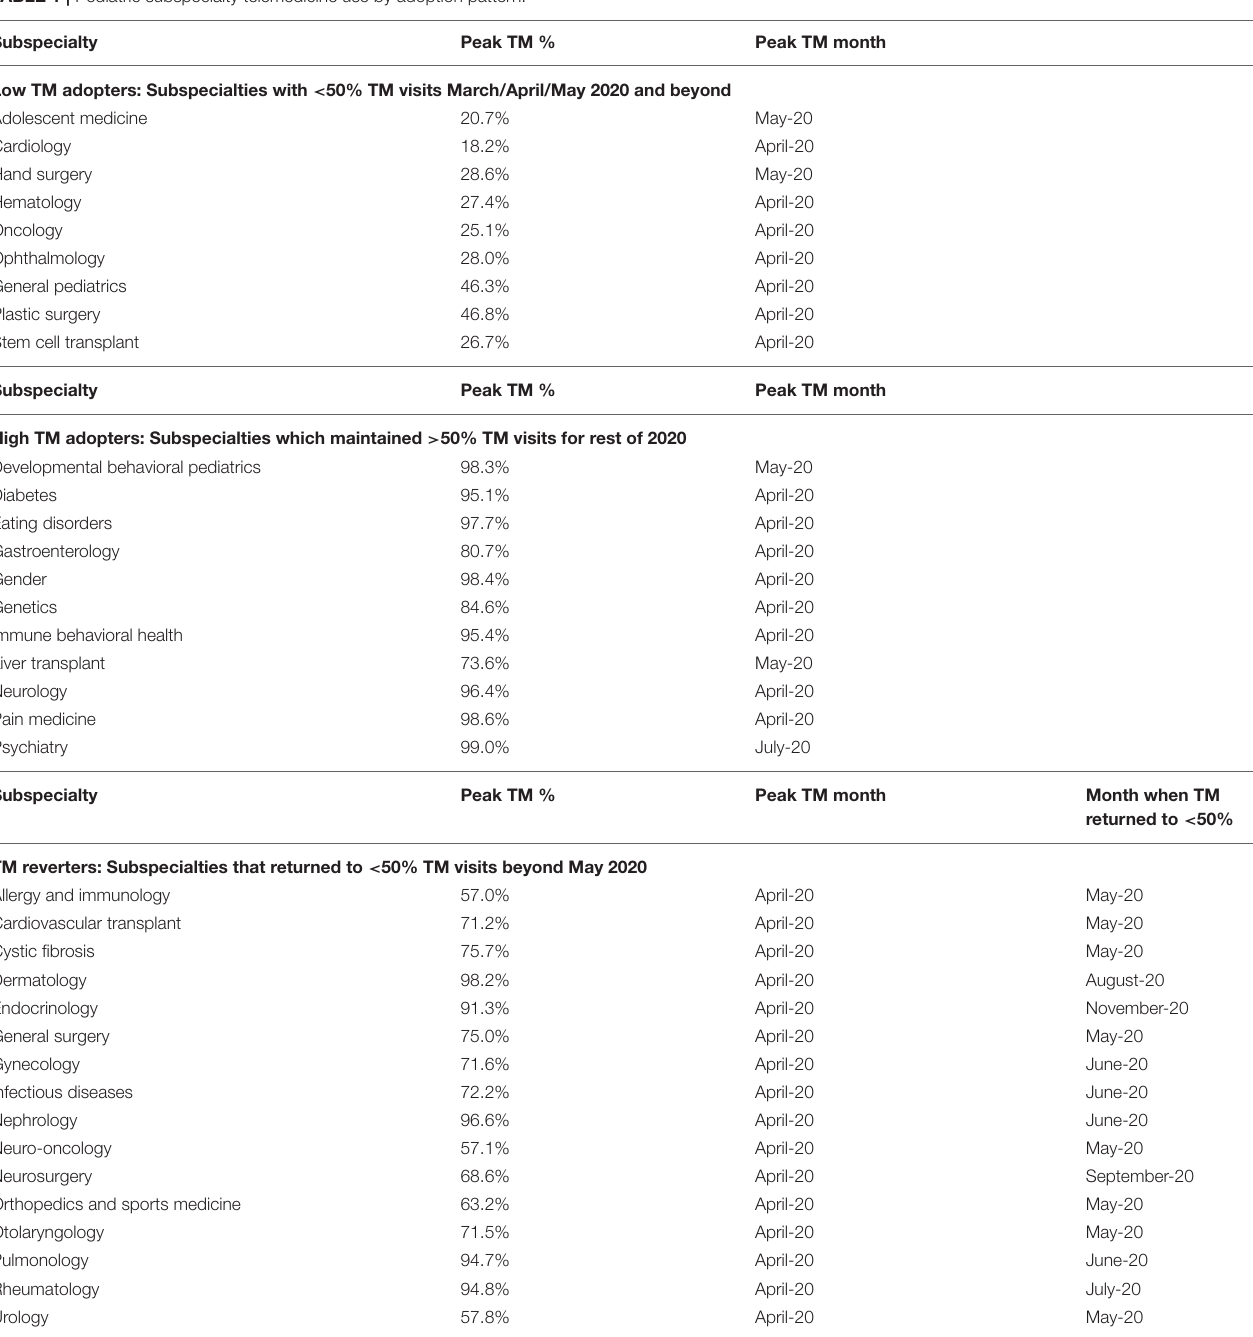
TABLE 1 | Pediatric subspecialty telemedicine use by adoption